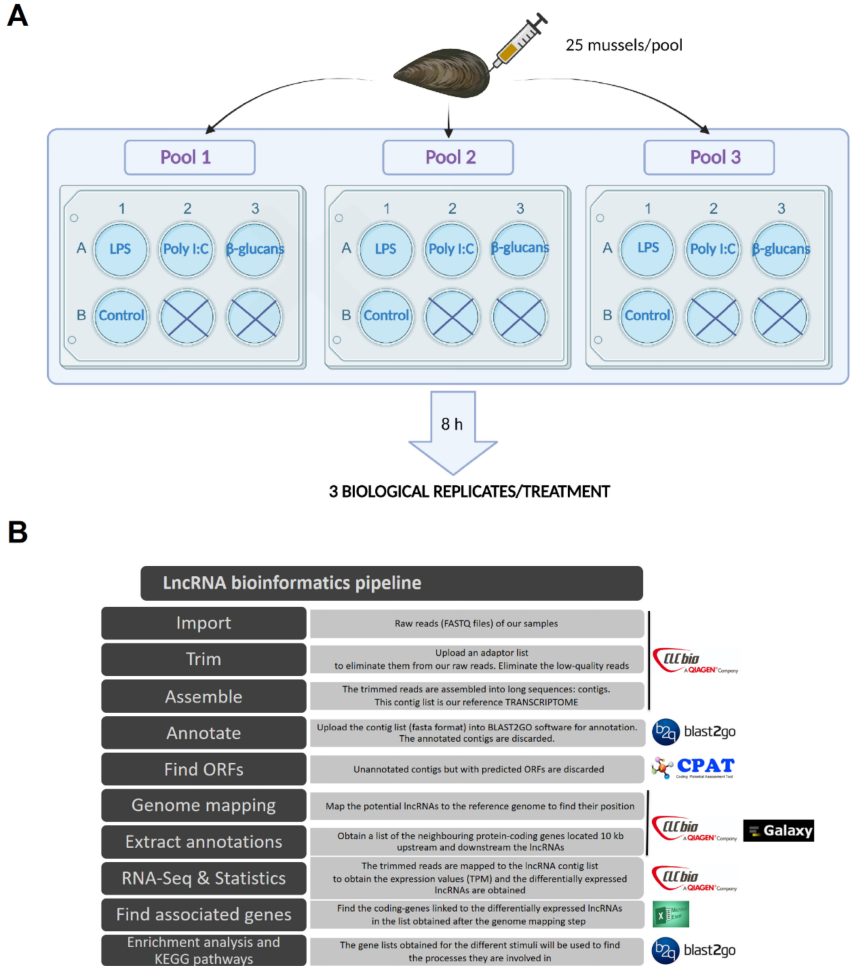
Figure 1. ( A ) Schematic representation of the experimental design and ( B ) bioinformatics pipeline conducted to analyze the M. galloprovincialis lncRNA